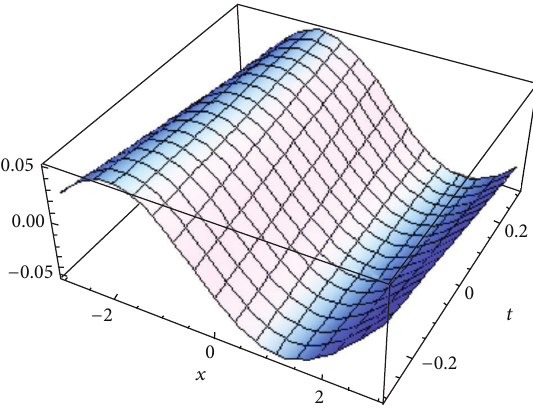
Figure 7: 3D, residual of 𝛽(𝑥,𝑡) at 𝑡 = 0.1